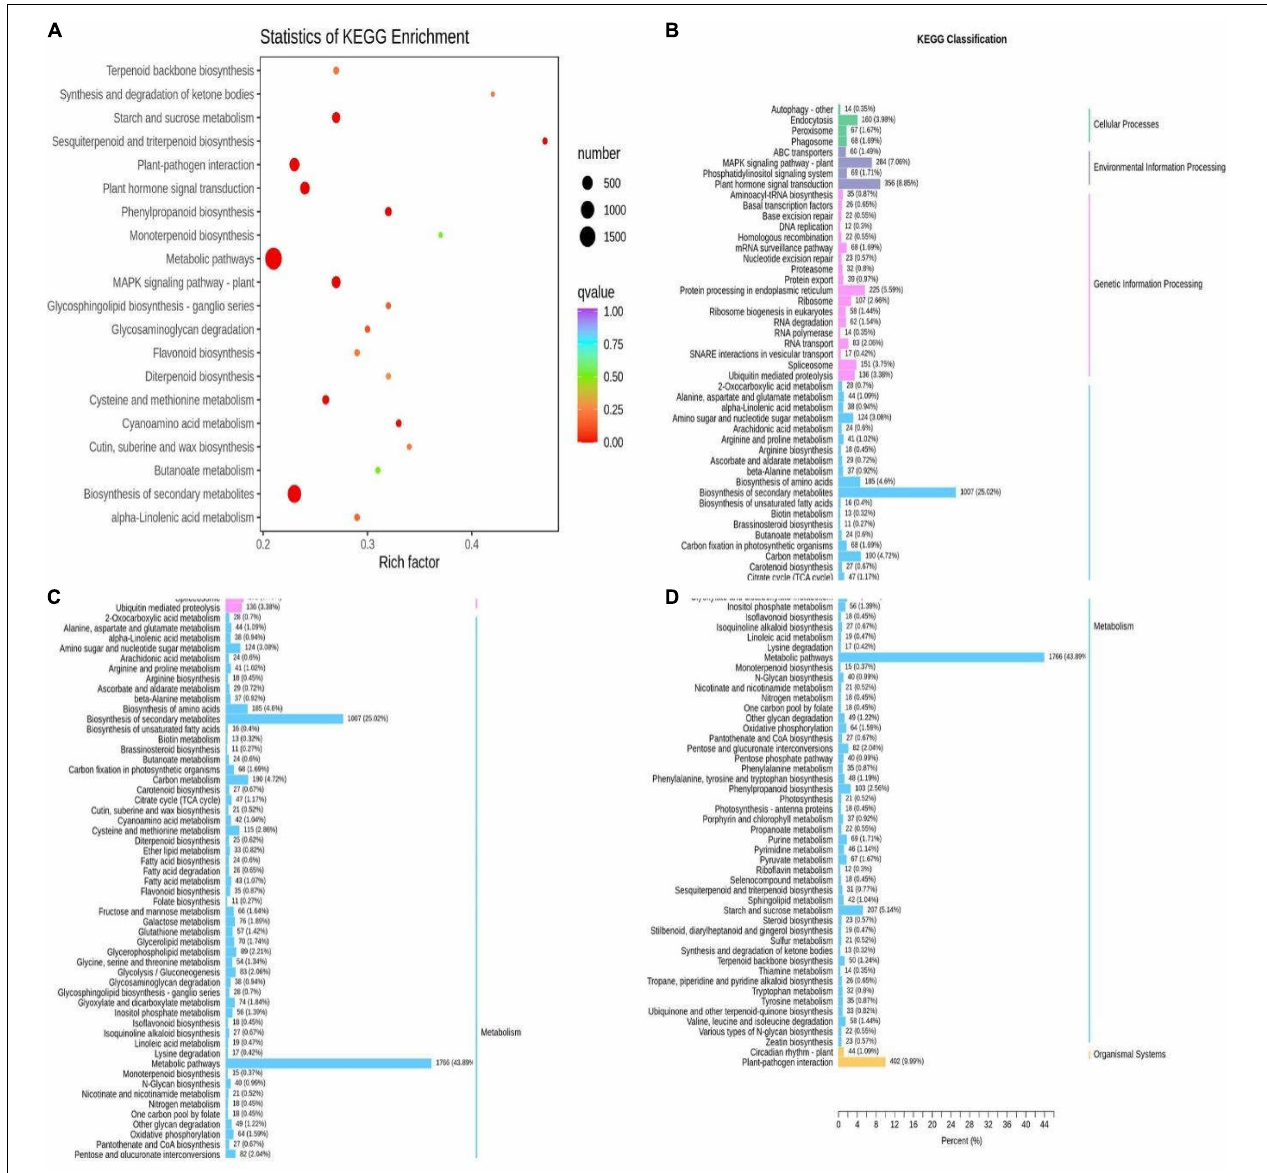
FIGURE 12 | Enrichment pathways of different genes in Qssg and Lc fruits. (A) Scatter diagram of enrichment of differential gene KEGG in Qssg and Lc fruits. (B–D) Column diagram of enrichment of differential gene GO in Qssg and